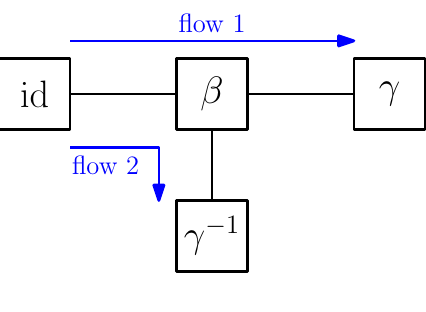
Figure 24 . A one-tensor